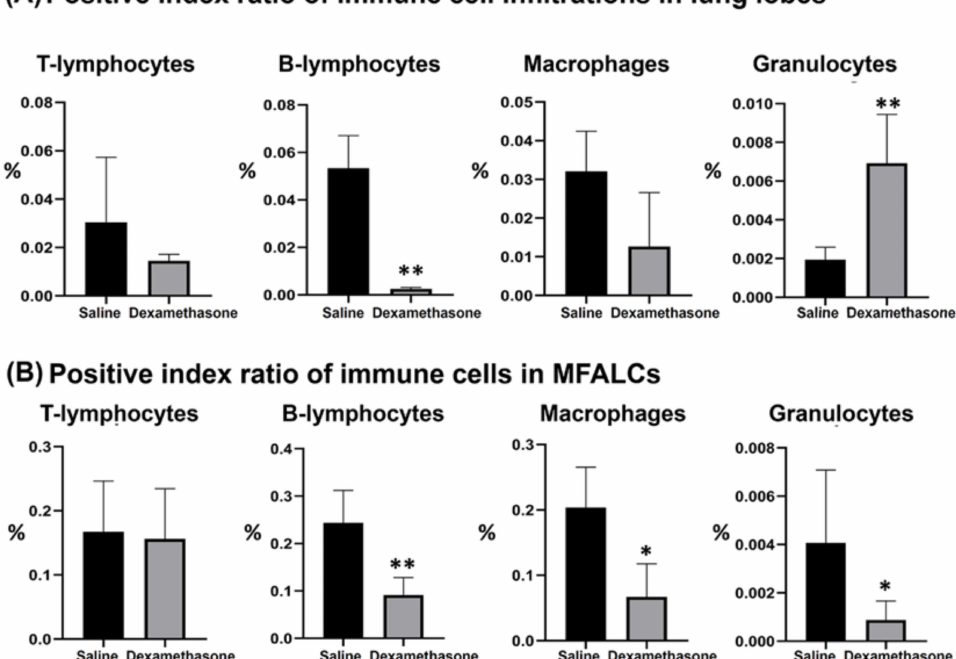
Figure 3. Morphometrical analysis of the effect of dexamethasone on immune cell populations in the lungs and mediastinal fat associated-lymphoid clusters (MFALCs) in female Lpr mice. ( A , B ) Rep- resentative graphs showing the percentage of the positive index ratios for CD3 + T-lymphocytes (Supplementary Figure S1A), B220 + B-lymphocytes (Supplementary Figure S1B), Iba-1 + macrophages (Supplementary Figure S1C), and Gr-1 + granulocytes (Supplementary Figure S1D) in the lungs ( A ) and MFALCs ( B ). Significant (*) and highly significant values (**) were observed between the saline and dexamethasone groups ( p values < 0.05, and <0.01, respectively), where n = 5 in each experimental group. Analysis was conducted using the Mann–Whitney U test. Data are presented as mean values ±